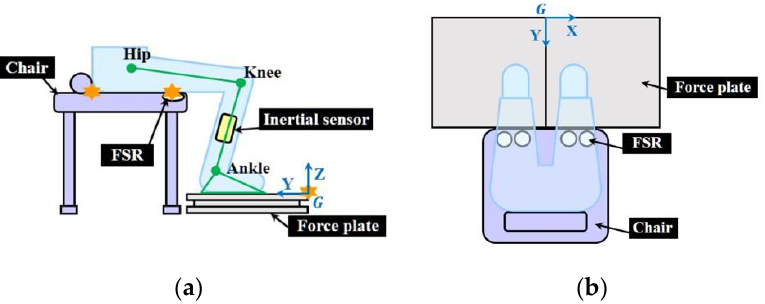
Figure 1. Schematic description of the proposed system in ( a ) YZ plane; ( b ) XY plane. Stars denote the landmarks for the system. FSR: force sensing resistor.